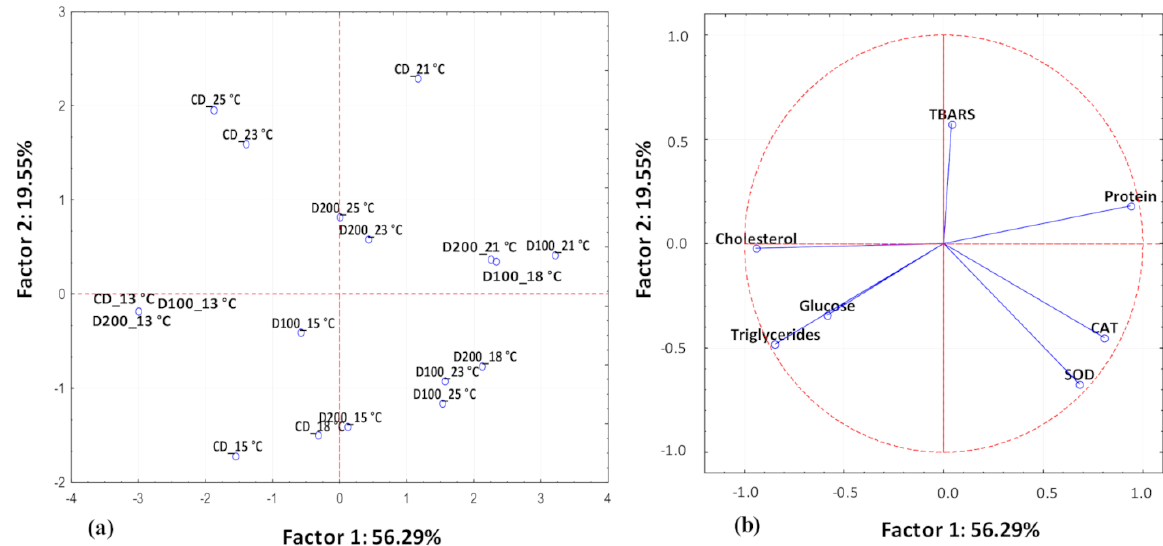
Figure 7. Score ( a ) and loading ( b ) plots of first and second principal components after principal component analysis performed on oxidative stress biomarkers and serum biochemical parameters in sea bass fed on control diet (CD) and experimental diets with different concentration of oregano essential oil (100 ppm (D100) and 200 ppm (D200)) and, exposed to different water temperatures (13, 15, 18, 21, 23, and 25 ◦